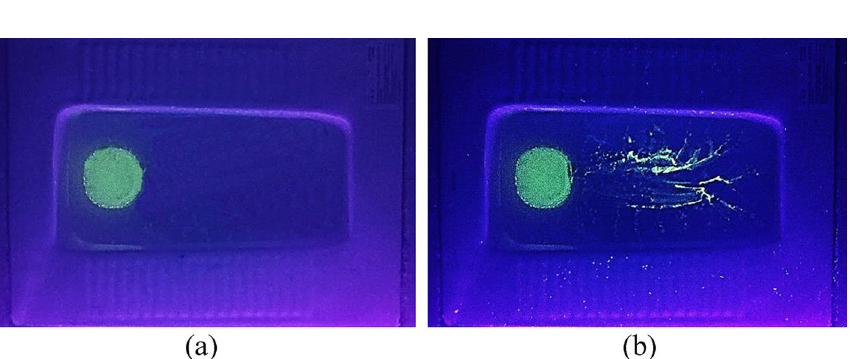
Figure 6. Deposition of fluorescent droplets/particles on the step area of the squat toilet: ( a ) before flushing, ( b ) after